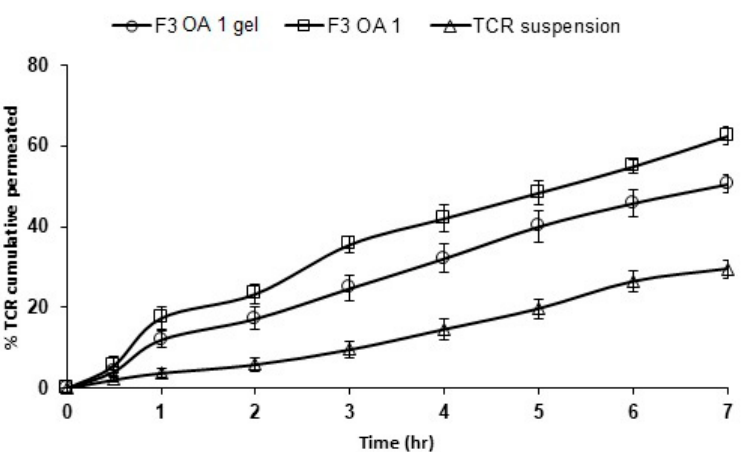
Figure 6. Ex vivo permeation of TCR from F3 OA 1 SPLs gel and F3 OA 1 SPLs ( n = 3, mean ± SD) in rat skin. Table 4. Ex vivo permeation parameters of TCR from selected SPLs (F3 OA 1) and F3 OA 1 gel formula ( n = 3, mean ±